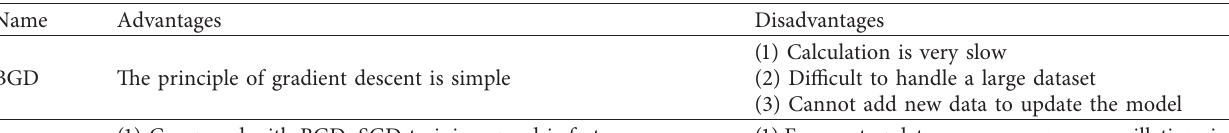
Table 6: Advantages and disadvantages of gradient descent